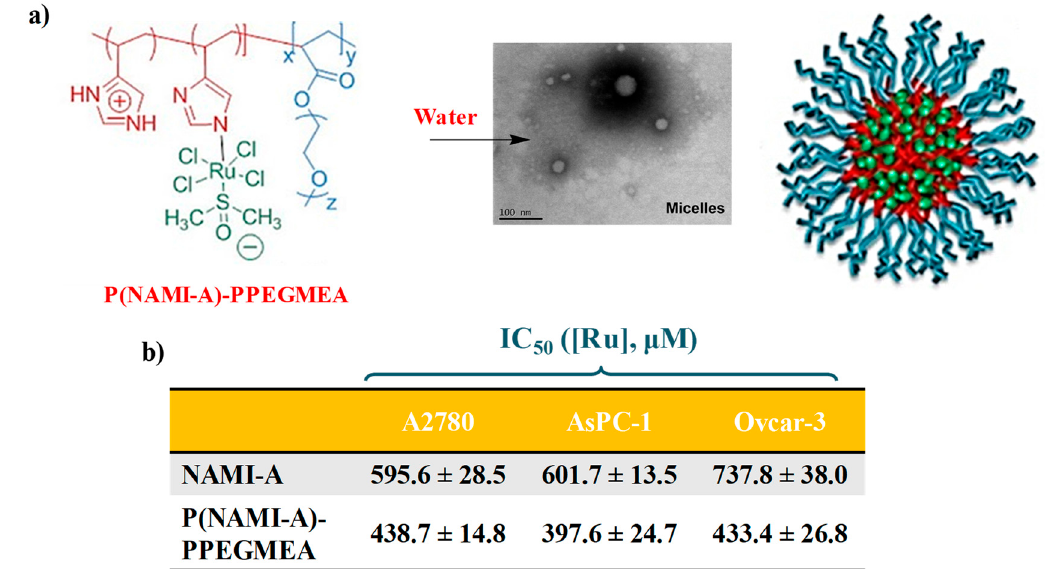
Figure 4. NAMI-A conjugation to polymeric micelles: ( a ) chemical structure of the amphiphilic block copolymer P(NAMI-A)-PPEGMEA and schematic representation of its micellization in water; ( b ) cytotoxicity and IC 50 values (µM, expressed in terms of ruthenium concentration) of NAMI-A and P(NAMI-A)-PPEGMEA against ovarian A2780 and Ovcar-3 and pancreatic AsPC-1 cancer cell lines. IC 50 values are reported as mean ± SEM. Figures were adapted with permission from [115] Copyright 2014 from American Chemical Society.